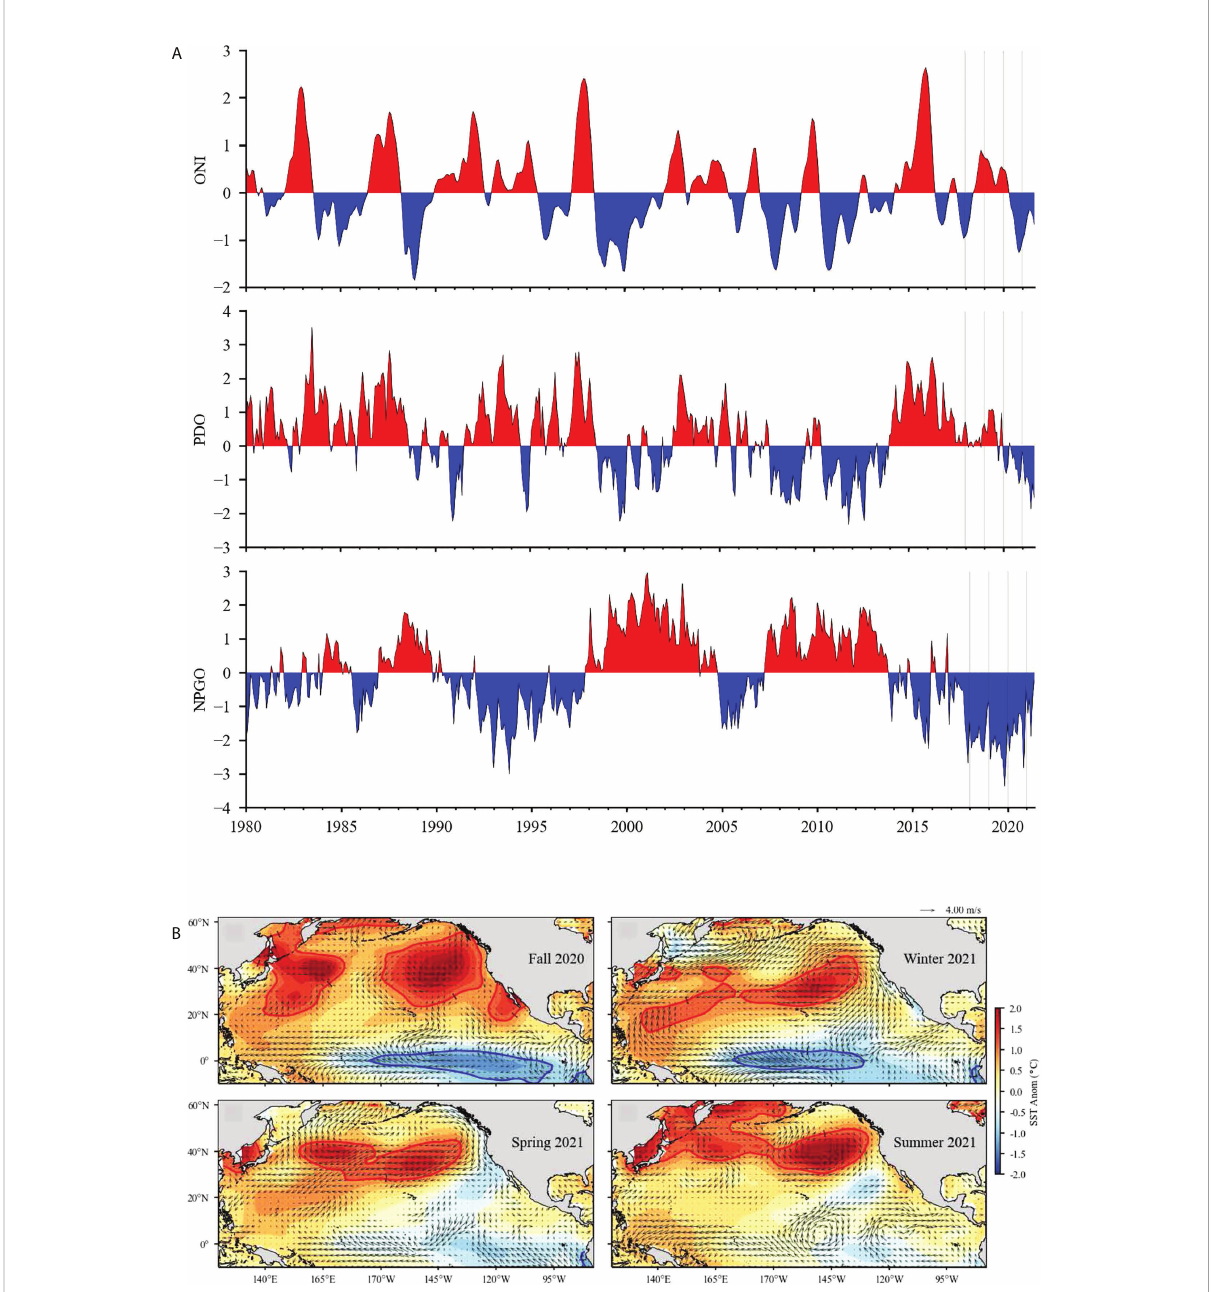
FIGURE 2 (A) Time series of monthly values for three ocean indices especially relevant to the California Current: Oceanic Niño Index (ONI), Paci fi c Decadal Oscillation (PDO), and North Paci fi c Gyre Oscillation (NPGO). Vertical lines mark January 2017 – 2021. (B) Surface wind velocity and sea surface temperature anomalies in the North Paci fi c Ocean for fall (September – November) 2020, winter (December – February) 2021, spring (March – May) 2021, and summer (June – August) 2021. Arrows denote the magnitude and direction of wind anomaly (scale arrow at the top). Contours denote temperature anomaly. Shading interval is 0.25°C and contour intervals at ±1°C are shown in red and blue,